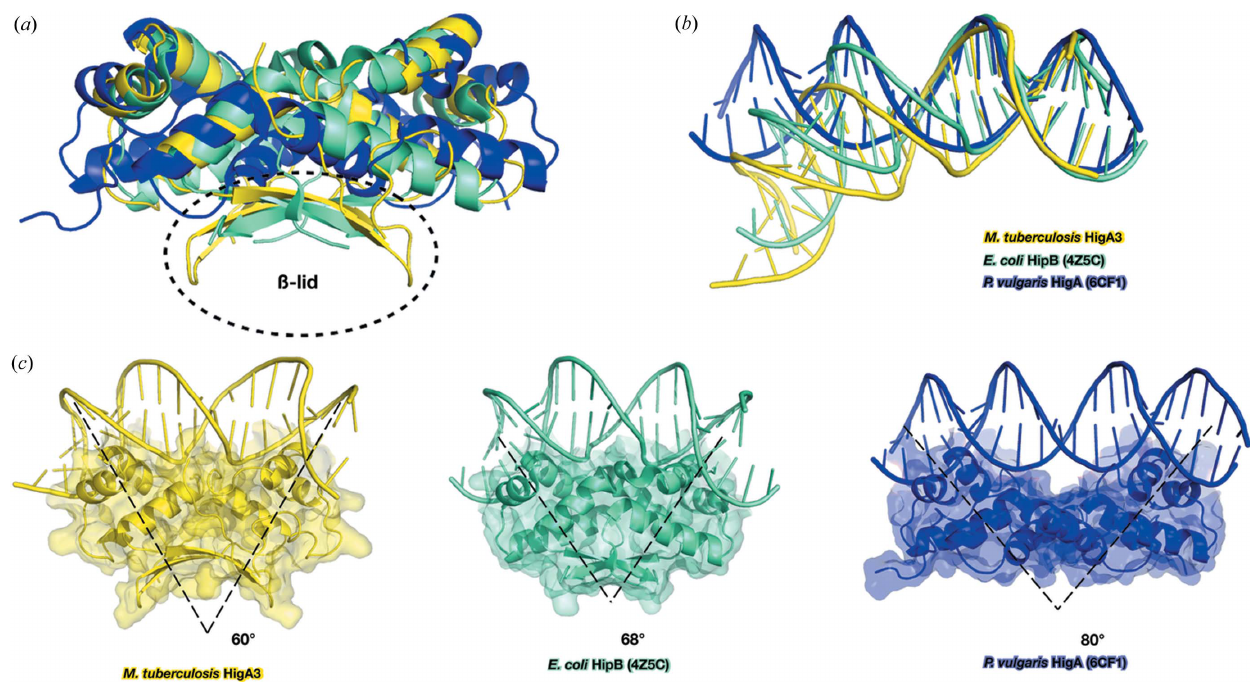
Figure 6 Structural comparison of Mt HigA3 bound to DNA and its homologues. ( a ) Cartoon representation of Mt HigA3 bound to DNA (yellow), Pv HigA bound to DNA (blue) and Ec HipB bound to DNA (cyan). The C-terminus of the antitoxin which differs markedly in comparison is marked with a black dotted circle. Only the protein structures in these DNA–protein complexes are shown for clarity. ( b ) The superimposed cartoon represents the DNA structure of Mt HigA3 bound to DNA (yellow), Pv HigA bound to DNA (blue) and Ec HipB bound to DNA (cyan). Only the DNA structures in these DNA– protein complexes are shown for clarity. ( c ) Structure of Mt HigA3 bound to DNA, Pv HigA bound to DNA and Ec HipB bound to DNA. The antitoxins are presented as cartoon diagrams in surface view. Dimer angles between central stalks are